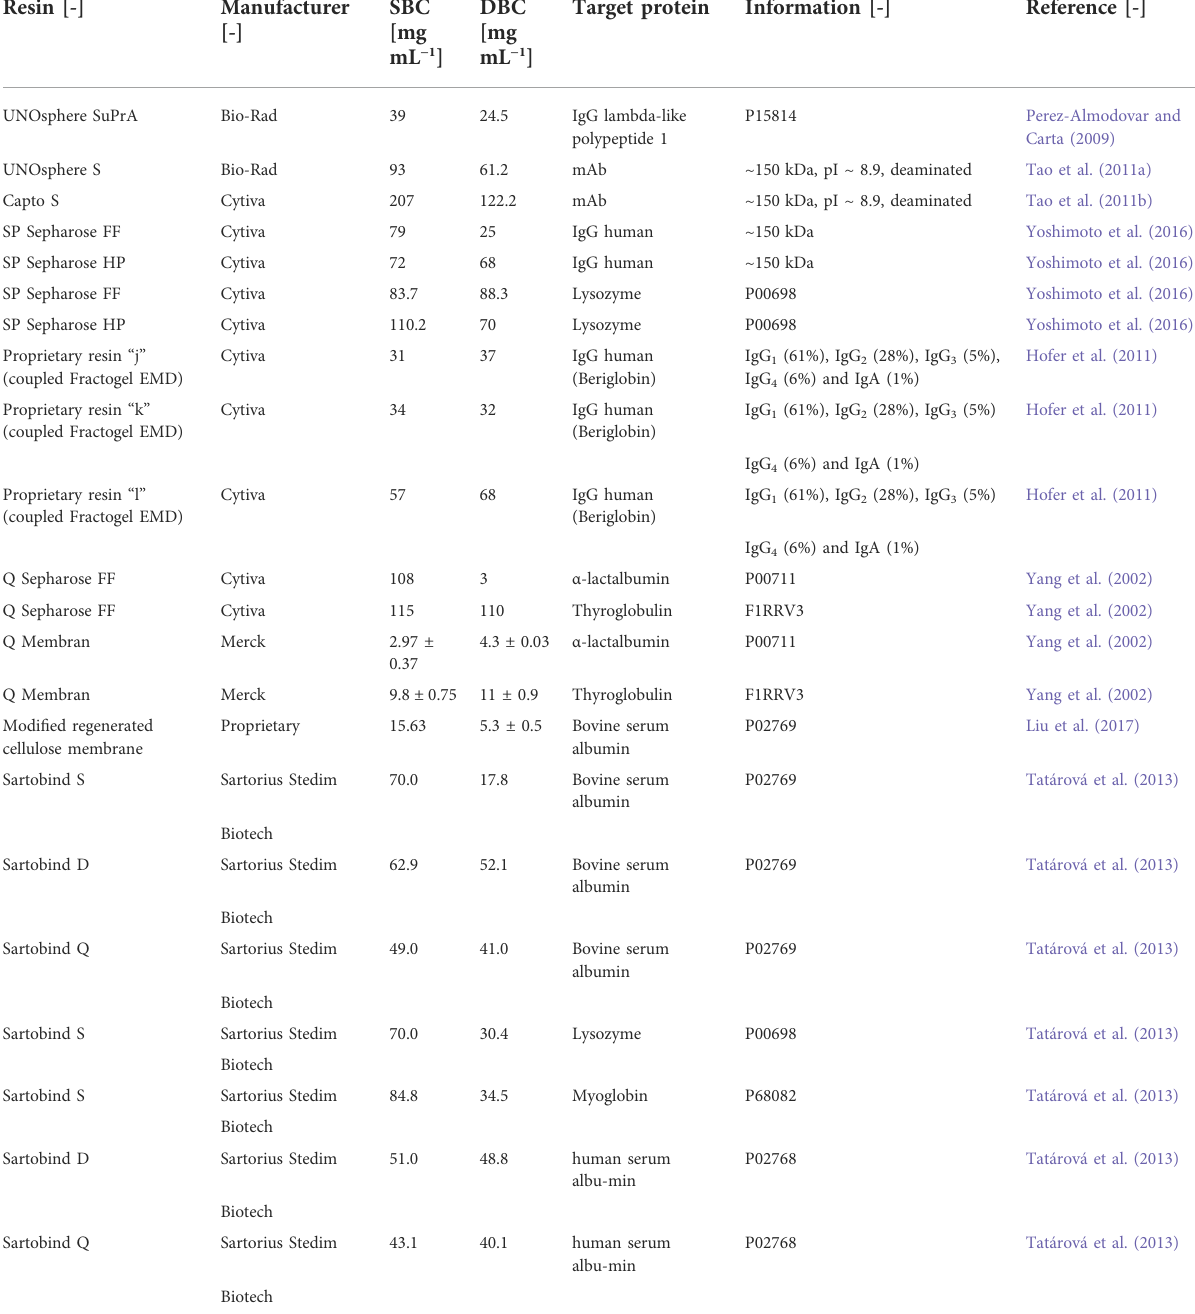
TABLE 4 Static and dynamic binding capacities obtained for different target proteins and chromatography resins. Resin